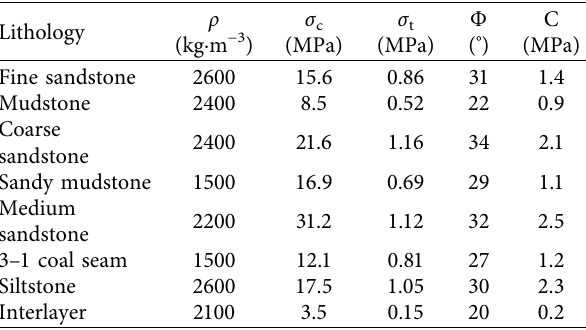
Table 3: Rock mechanical parameter of open-off